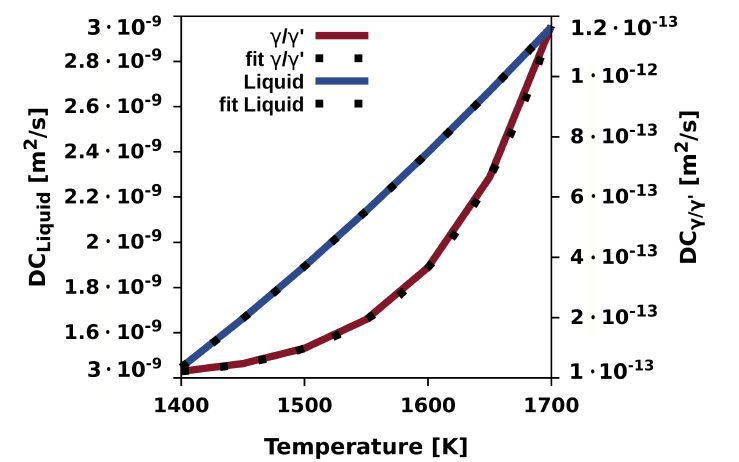
Figure 2. Plot of the diffusion coefficients of Al in the liquid and the solid phases and the correspond- ing fitting function within the relevant temperature range for the solidification simulation.